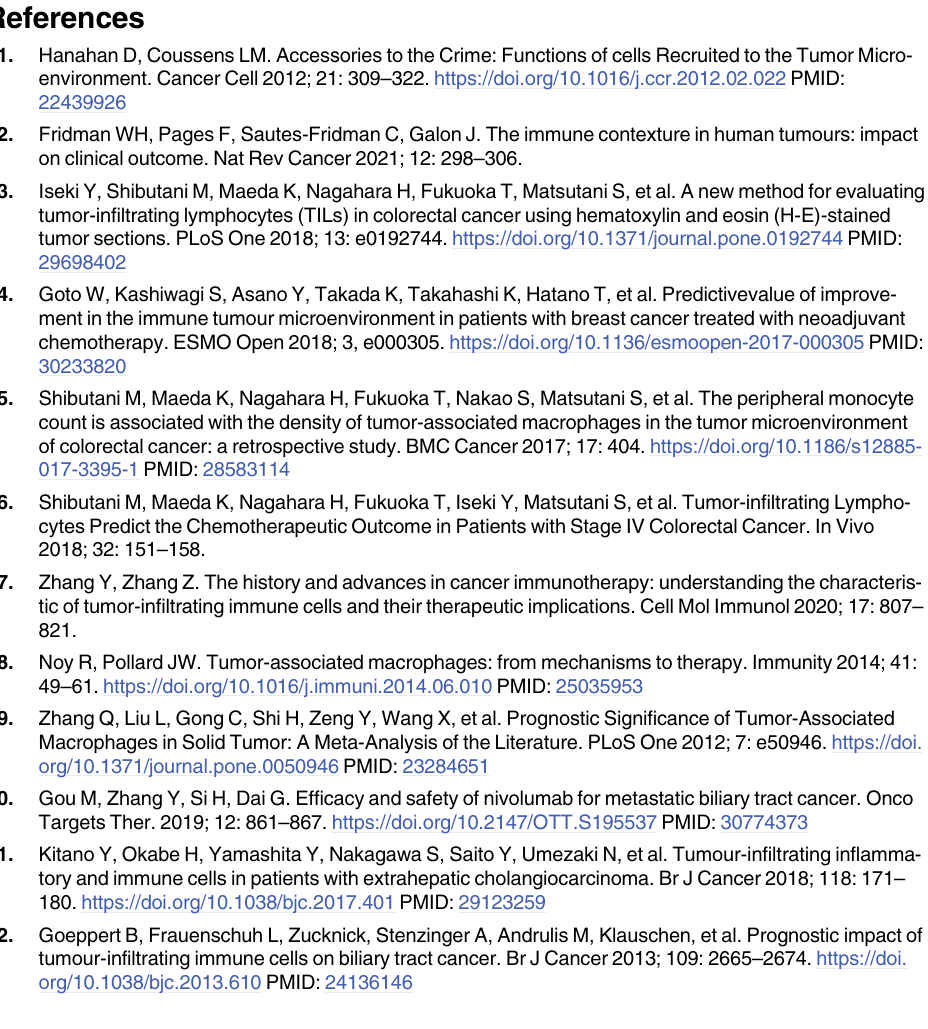
S2 Table. Multivariate cox regression analysis for overall and recurrence free survival in 130 patients with